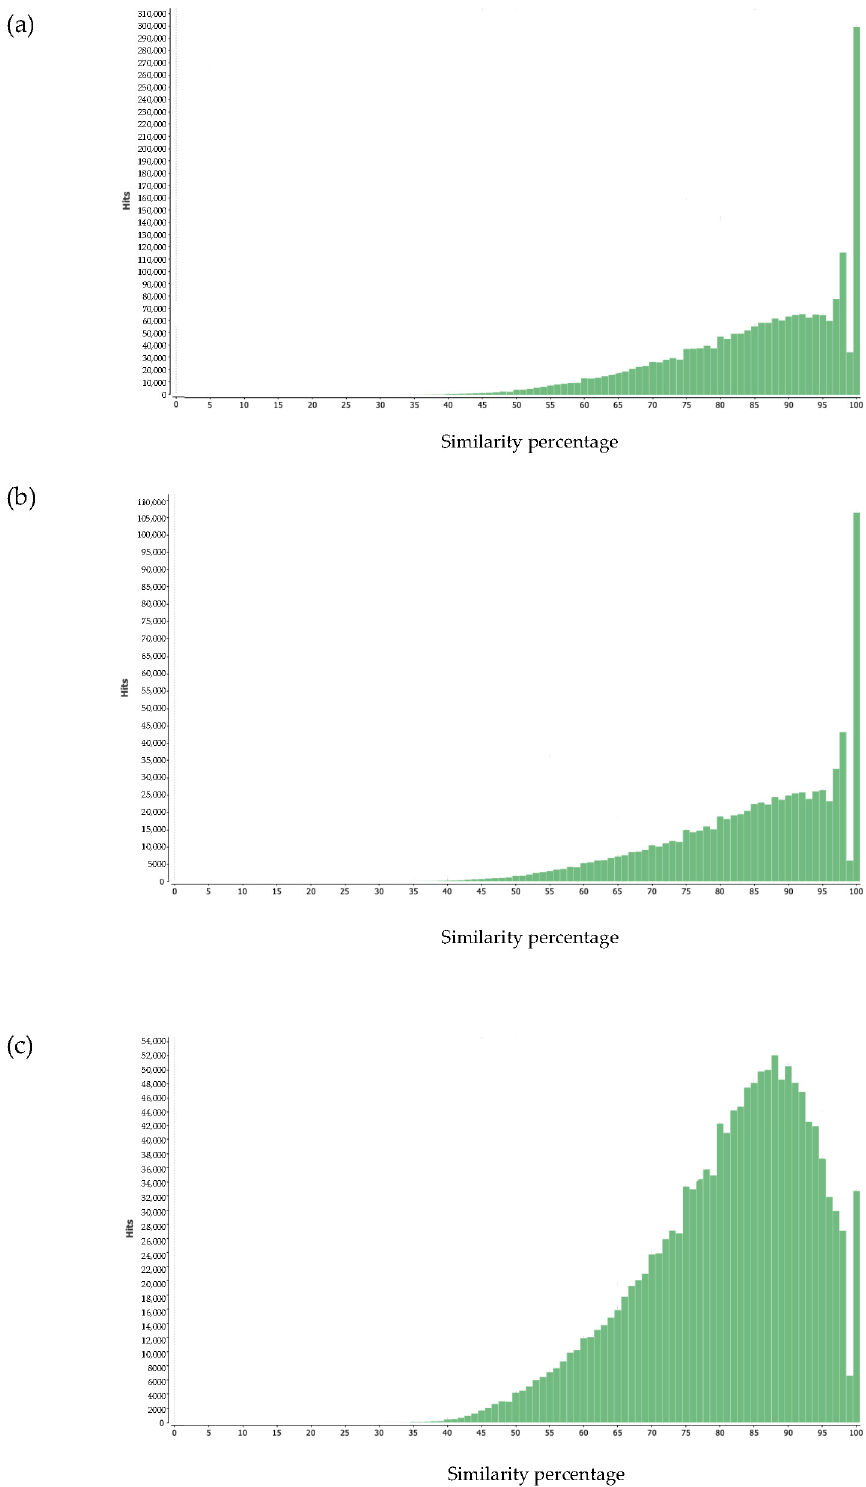
Figure 4. A annotation unigenes of flower part of ( a ) H. cagayanensis ; ( b ) H. lacunose ; and ( c ) H. coriacea from NR database: the percentage of similarity of sequences identified using blastx program.